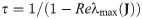
Dynamical regimes for a network of two interacting populations.A. Relation between the eigenvalues of the connectivity matrix J (blue dots) and the eigenvalues of its symmetric part, JS (red dots). Both pairs of eigenvalues are symmetrically centered around Tr(J)/2, but the eigenvalues of JS lie further apart (Eq 4), and the maximal eigenvalue of JS can cross unity if the difference 2Δ between the off-diagonal elements of the connectivity matrix is sufficiently large (bottom panel). B. Value of the maximum amplification of the system (quantified by the maximal singular value σ1(Pt*) of the propagator, see Methods) as a function of the non-normal parameter Δ. Here we fix the two eigenvalues of J, the largest of which effectively determines the largest timescale of the dynamics, and vary Δ. Colored traces correspond to different values of the largest timescale of the system τ=1/(1-Reλmax(J)). For small values of Δ the maximum amplification is equal to one, and it increases approximately linearly when Δ is larger than the critical value. Each colored trace corresponds to a different choice of Tr(J) and Det(J). From top to bottom traces: Tr(J) = 0, −0.5, −2, −4 and Det(J) = Tr2(J)/4 (for convenience), corresponding respectively to τ = 1, 0.8, 0.5, 0.33. The trace for τ = 1 corresponds to Reλmax(J)=0. C. Dynamical regimes for an excitatory-inhibitory two population model, as in [32]. Here w represents the weights of the excitatory connections (JEE = JIE = w) and −kw the weights of the inhibitory ones (JEI = JII = −kw). The inhibition-dominated regime corresponds to k > 1. The color code corresponds to the maximum amplification, as quantified by the maximal singular value σ1(Pt*). The grey trace corresponds to the boundary between the monotonic and the amplified parameter regions. The red trace represents the stability boundary, with the unstable region hatched in red. In order to achieve transient amplification the excitatory weight w has to be approximately larger than unity, when k is larger than but close to one. Note that amplification can be obtained also for 0 < k < 1, in a parameter region limited by the stability boundary.